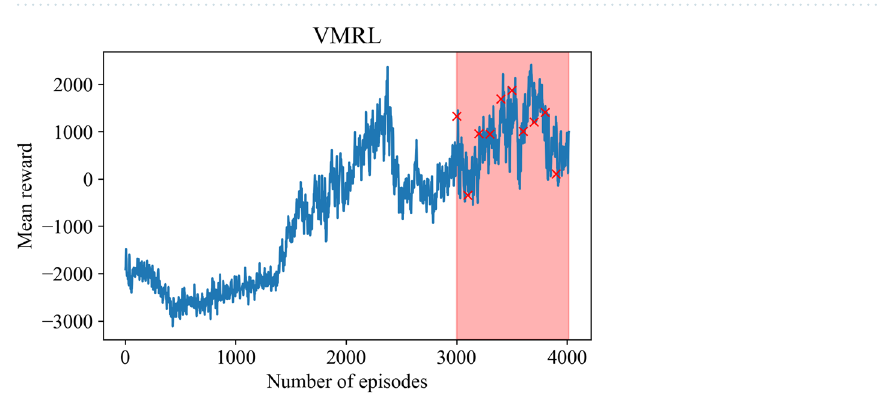
Figure 7. Evolution of the moving average mean reward for VMRL approaches. The models used for testing are indicated by red